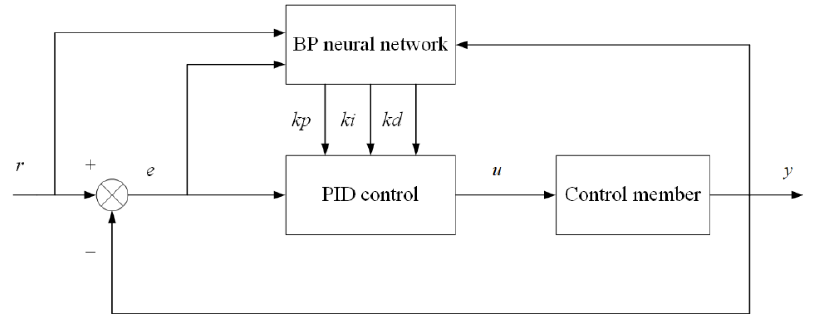
Figure 4. Schematic diagram of neural network PID control.